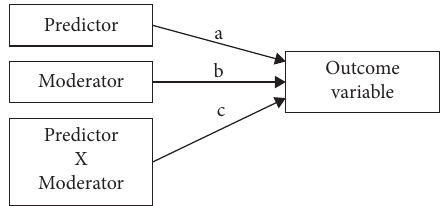
Figure 2: Regulatory effect analysis